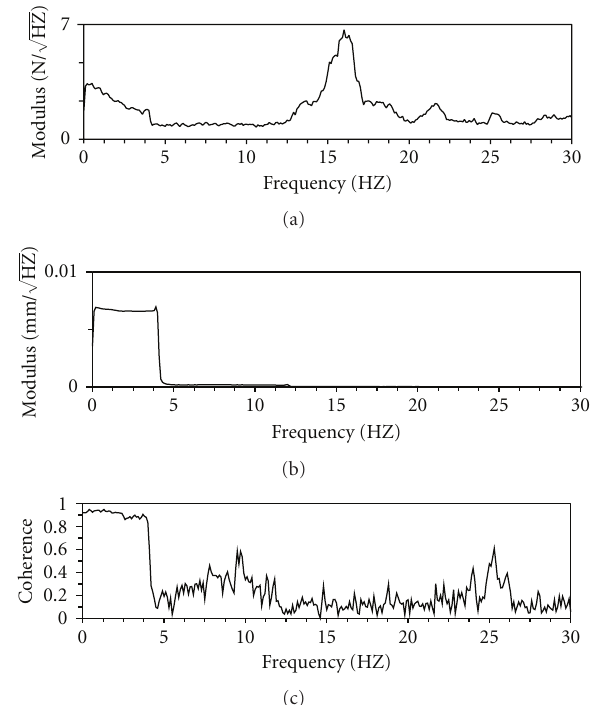
Figure 8: Square root of the autospectral density of f aligned versus frequency (a); square root of the autospectral density of u central versus frequency (b); coherence between f aligned and u central versus frequency (c); for a 4.2 m/s fluid